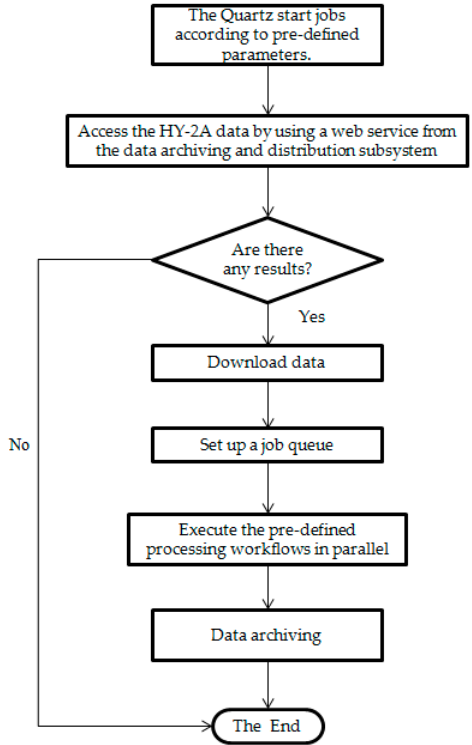
Figure 2. The flow chart of the routine customized processing.